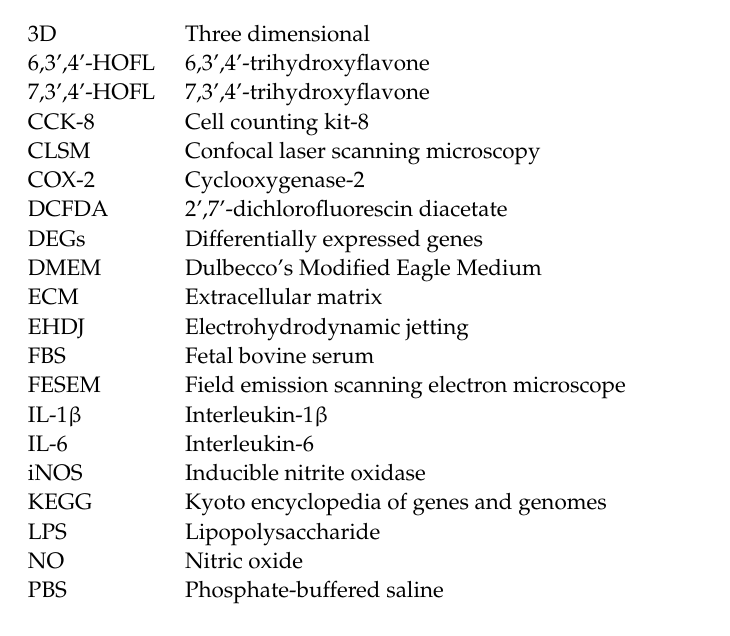
S3: Volcano plots analysis of differential expression genes (DEGs) in RAW 264.7 cells; Figure S4: Protein expression of pp65/p65 (a), pp38/p38 (b), pJNK/JNK (c), pERK/ERK (d), and their bands (e); Figure S5: Application of natural fluorescent 7,3’,4’-HOFL for receptor finding; Table S1: Sequences of primers for RT-qPCR; Table S2: Overview of RNA-Sequencing reads. The replicates of Western blotting results are provided in the File